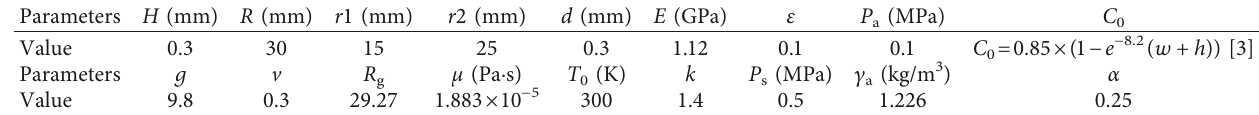
Table 1: Numerical calculation